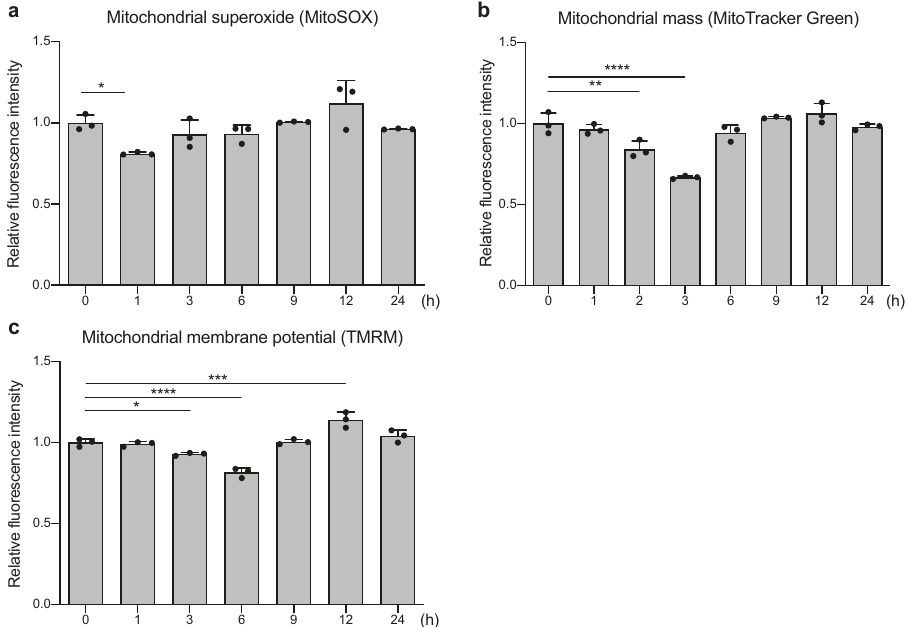
Fig. 2 Opti-ELF-WMF temporarily decreased the levels of mitochondrial reactive oxygen species (ROS), mitochondrial mass, and mitochondrial membrane potential. a Mitochondrial ROS of mouse hepatocyte-derived AML12 cells exposed to Opti-ELF-WMF for 1 to 24 h was evaluated by MitoSOX. b Mitochondrial mass of AML12 cells exposed to Opti-ELF-WMF for 1 to 24 h was evaluated by MitoTracker Green. c Mitochondrial membrane potential of AML12 cells exposed to Opti-ELF-WMF for 1 to 24 h was evaluated by tetramethylrhodamine (TMRM). a – c Show mean ± SD, n = 3 culture dishes each; * p < 0.05, ** p < 0.01, *** p < 0.001, and **** p < 0.0001 by one-way ANOVA followed by Dunnett ’ s post hoc test compared with the value at time 0. COMMUNICATIONS BIOLOGY| (2022) 5:453